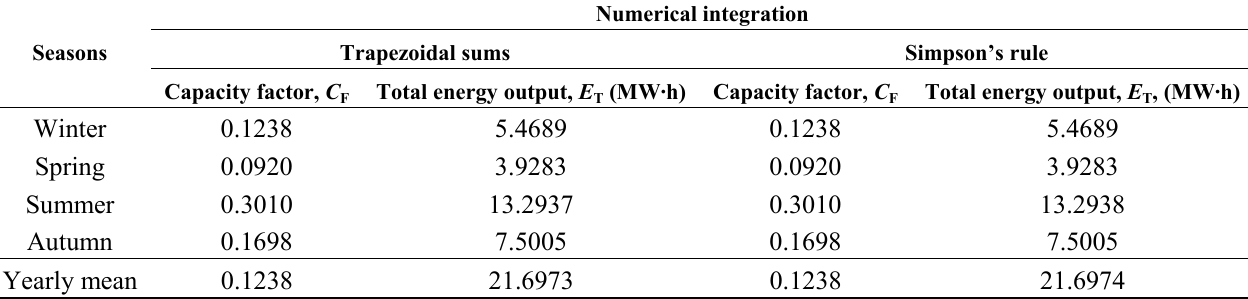
Table 16. Energy generated by the wind turbine and the capacity factor by numerical integration. The turbine rated power is 20 kW or 0.02 MW, rated speed is 8 m/s and hub height at 30